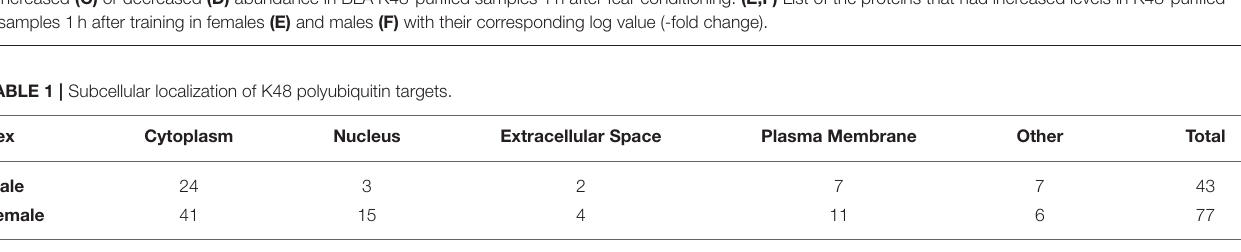
FIGURE 1 | Samples were purified with a K48-specific tandem ubiquitin binding entity (K48-TUBE), target proteins identified with liquid chromatography mass spectrometry (MC/MS) and compared with naïve rats ( n = 5 per sex). (A) Behavioral performance of animals during the training session. (B) Venn diagram showing the total K48 polyubiquitinated proteins identified in female (purple) and male (gray) BLA tissue. (C,D) Venn diagram showing the number of proteins that had increased (C) or decreased (D) abundance in BLA K48-purified samples 1h after fear conditioning. (E,F) List of the proteins that had increased levels in K48-purified samples 1h after training in females (E) and males (F) with their corresponding log value (-fold change).